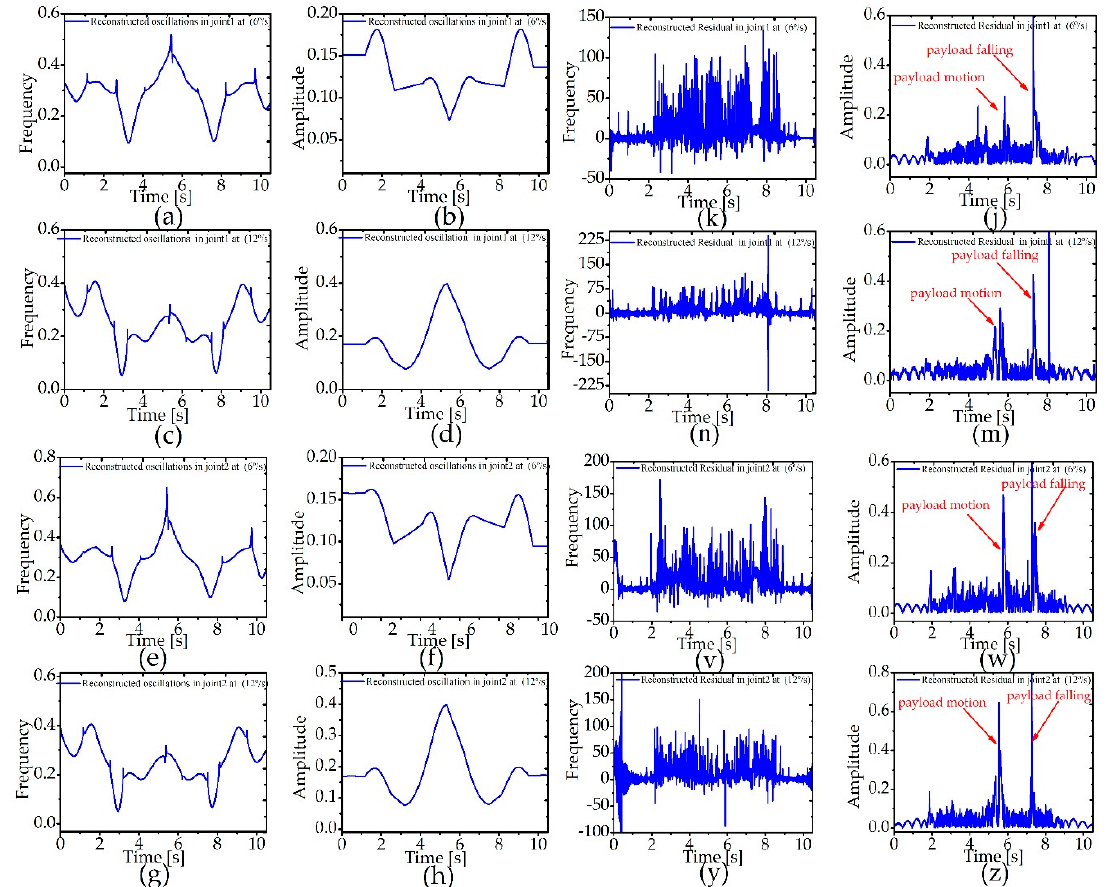
Figure 18. IA and IF of velocity for both oscillations and residual at two speeds. Case 1: ( a ) IF of oscillations in joint 1 at 6°/s, ( b ) IA of oscillations in joint 1 at 6°/s, ( k ) IF of residual in joint 1 at 6°/s, ( j ) IA of residual in joint 1 at 6°/s, Case 2: ( c ) IF of oscillations in joint 1 at 12°/s, ( d ) IA of oscillations in joint 1 at 12°/s, ( n ) IF of residual in joint 1 at 12°/s, ( m ) IA of residual in joint 1 at 12°/s, Case 3: ( e ) IF of oscillations in joint 2 at 6°/s, ( f ) IA of oscillations in joint 2 at 6°/s, ( v ) IF of residual in joint 2 at 6°/s, ( w ) IA of residual in joint 2 at 6°/s, Case 4: ( g ) IF of oscillations in joint 2 at 12°/s, ( h ) IA of oscillations in joint 2 at 12°/s, ( y ) IF of residual in joint 2 at 12°/s, ( z ) IA of residual in joint 2 at 12 ° /s. Table 7. Mean Frequency (MF) and Standard Deviation Frequency (STDF) for both position and velocity for the reconstructed oscillations by the SSAHT technique. (Unit: ° ).